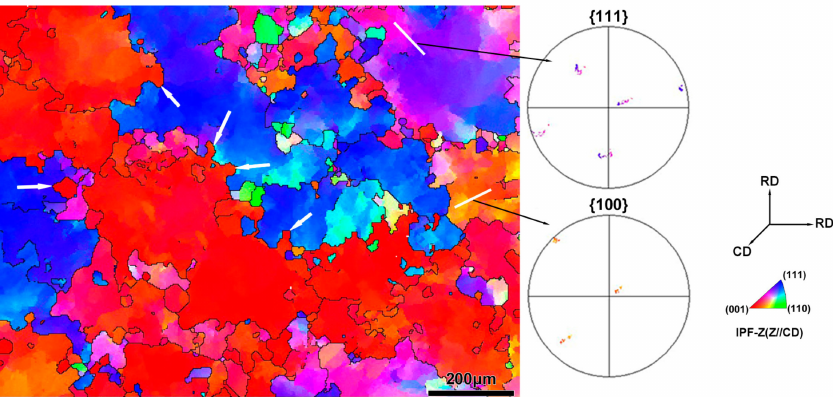
Figure 6. EBSD map with IPF colors of a sample at a strain rate of 0.01 s − 1 and 40% reductions at 1153 K perpendicular to CD (compressing direction); bowed grain boundaries during migration are shown with white arrows; variation in orientation of deformed grains are shown with {111} and {100} pole